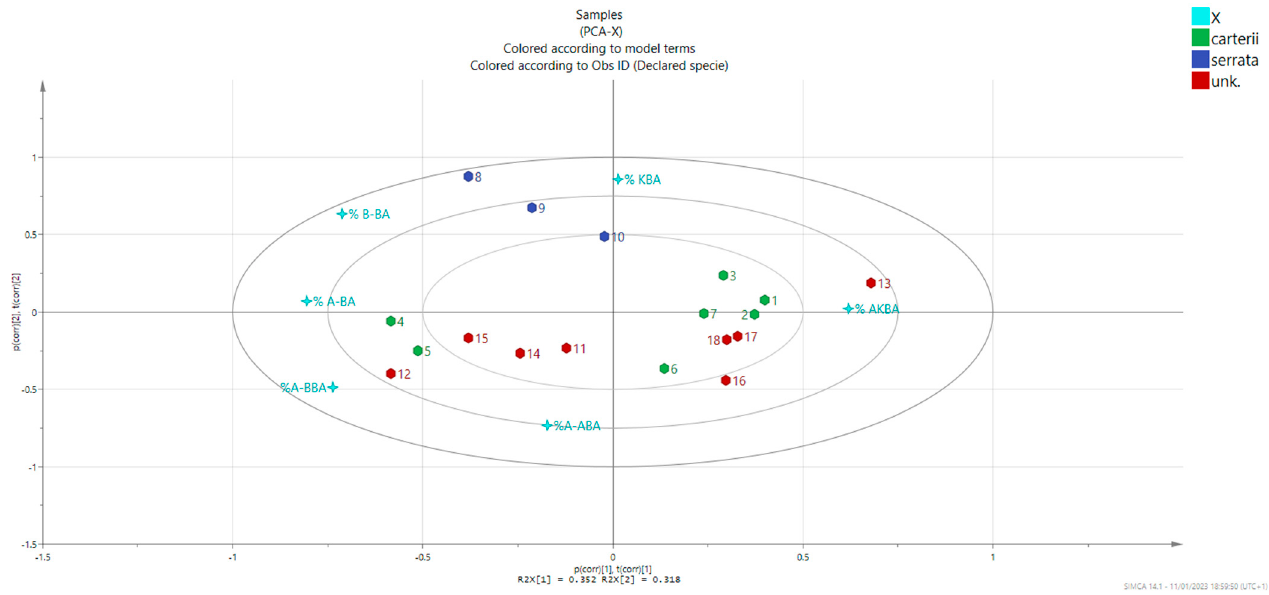
Figure 1. Biplot of the PCA model for the set of analyzed samples belonging to B. carteri , B. serrata and unknown species; each circular dot represents a sample, while each violet diamond represents the loading of each variable.